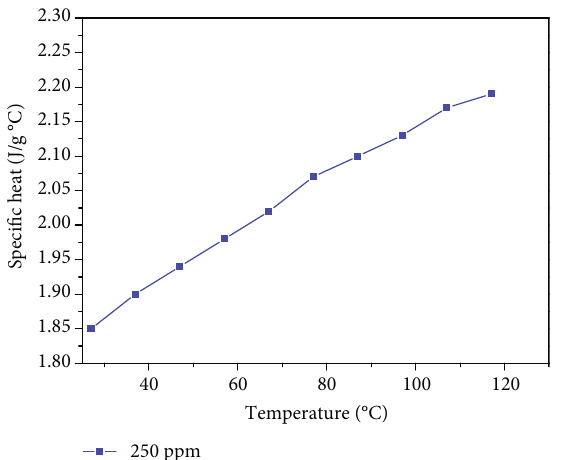
Figure 11: Speci fi c heat variation of 250 ppm Therminol 55-TiO nano fl